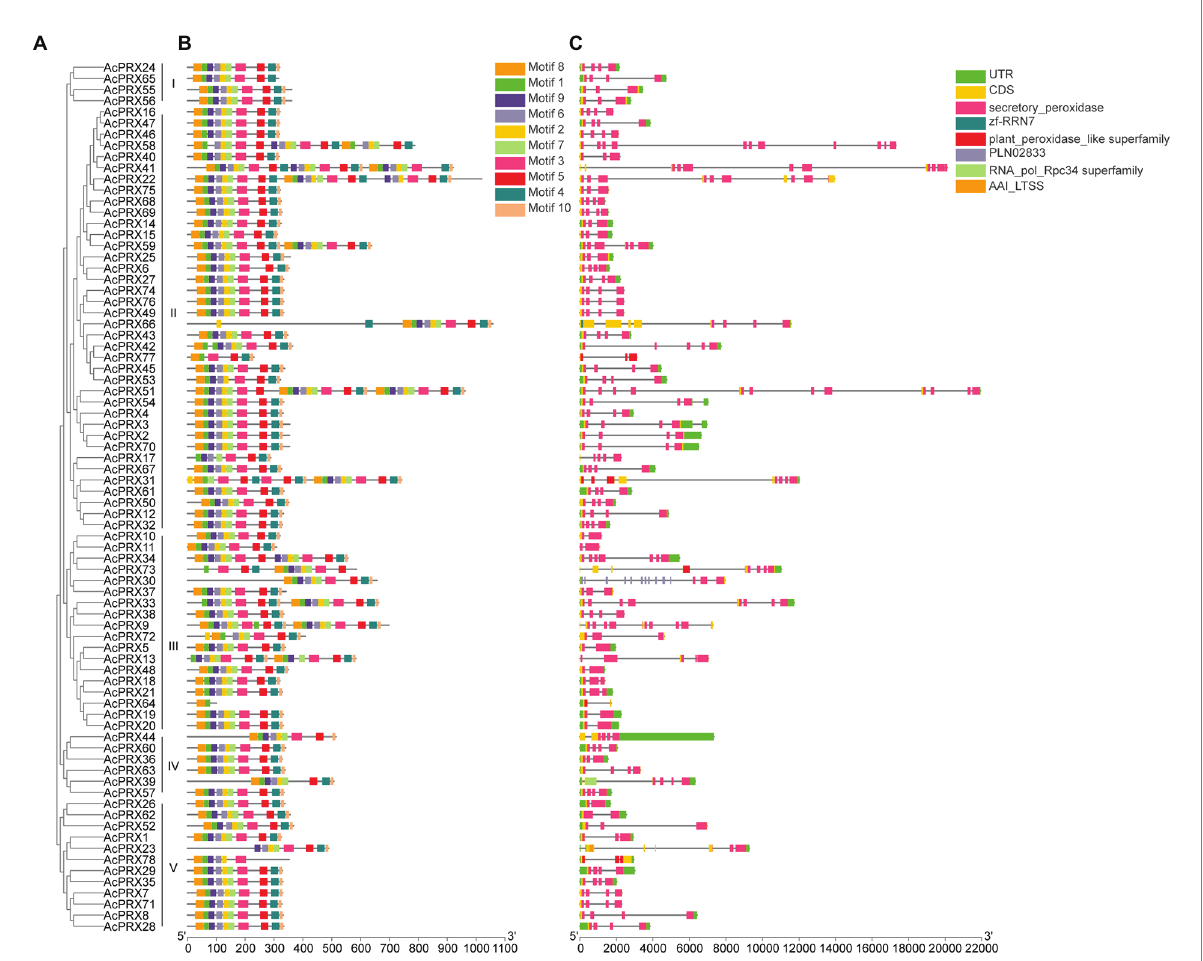
FIGURE 5 The conserved exon-intron structure and motif analyses of AcPRXs . (A) The full-length amino acid sequences of 78 AcPRX proteins were used to construct an unrooted neighbour-joining phylogenetic tree with 1,000 bootstrap replicates. (B) Organization of conserved motifs in AcPRXs. There were a total of 10 inferred motifs represented by different coloured boxes. Detailed information for each motif can be found in Table 2. (C) Exon-intron structure of AcPRXs . Grey lines indicate introns and yellow boxes indicate exons. The blue boxes represent 5 ′ and 3 ′ untranslated regions. The scales at the bottom illustrate the size of introns and exons.